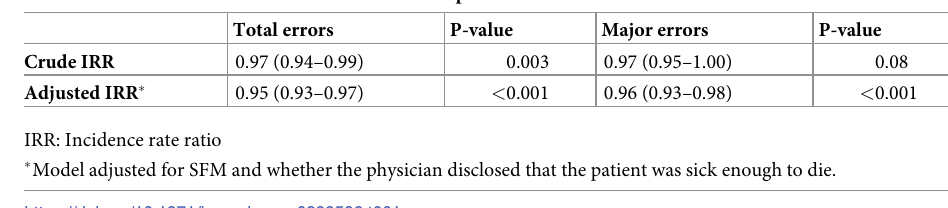
Table 1. Association between additional simulation performances and error incidence